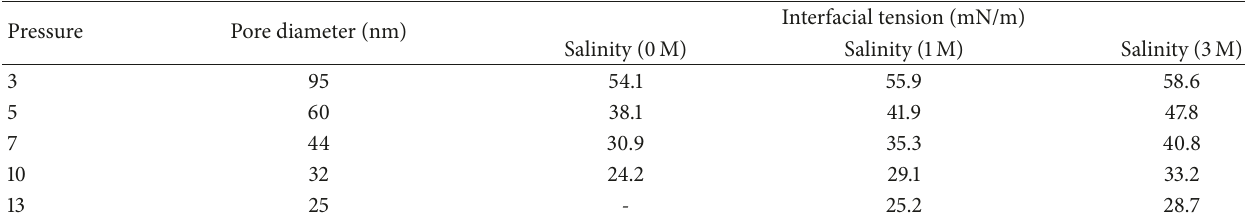
Table 1: The parameters used to calculate capillary pressure in different effective stress or depths. Pressure Pore diameter